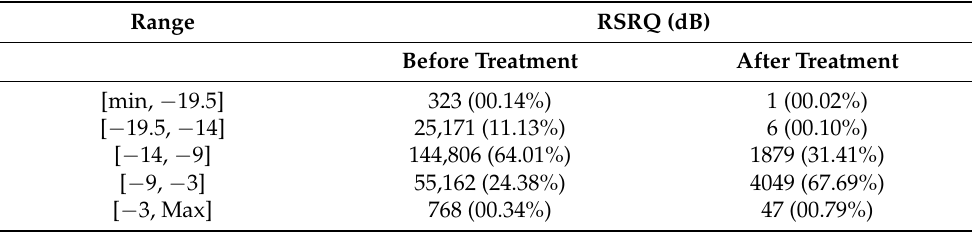
Table 2. RSRQ values before and after treatment.